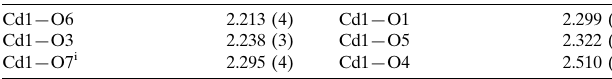
Selected bond lengths (A˚ ).